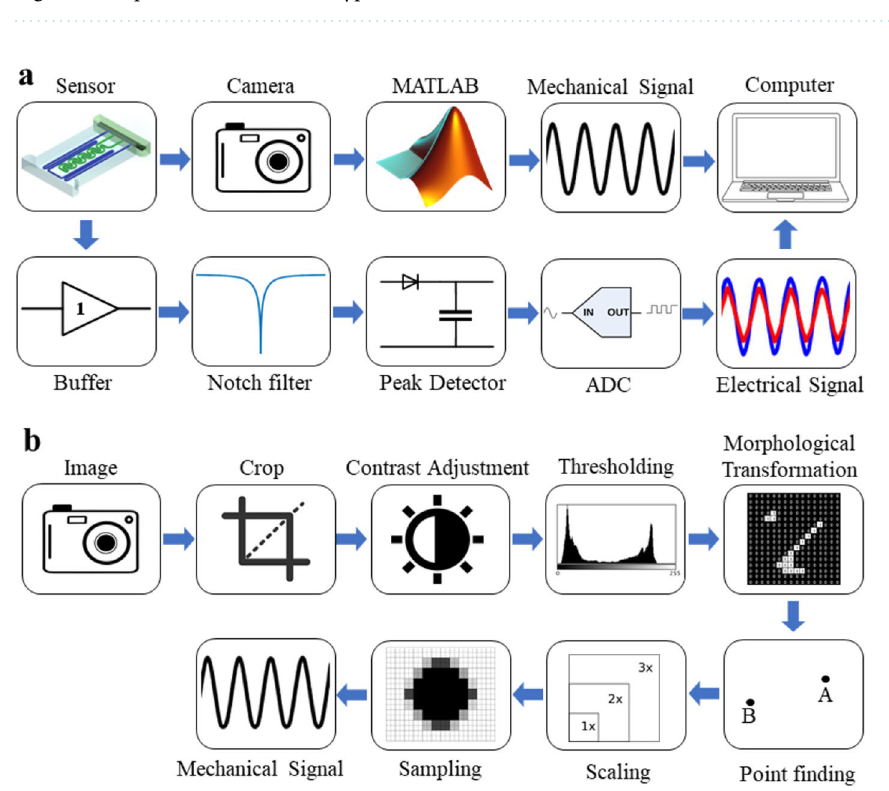
Figure 7. Block diagram of sensor’s testing setup. ( a ) Depicts the hardware configuration block diagram for measuring the applied mechanical signal and electrical response of the proposed sensors to the corresponding applied mechanical signals such as stretch and twist with different waveforms, ( b ) block diagram of utilizing image processing techniques to capture mechanical tension applied to the